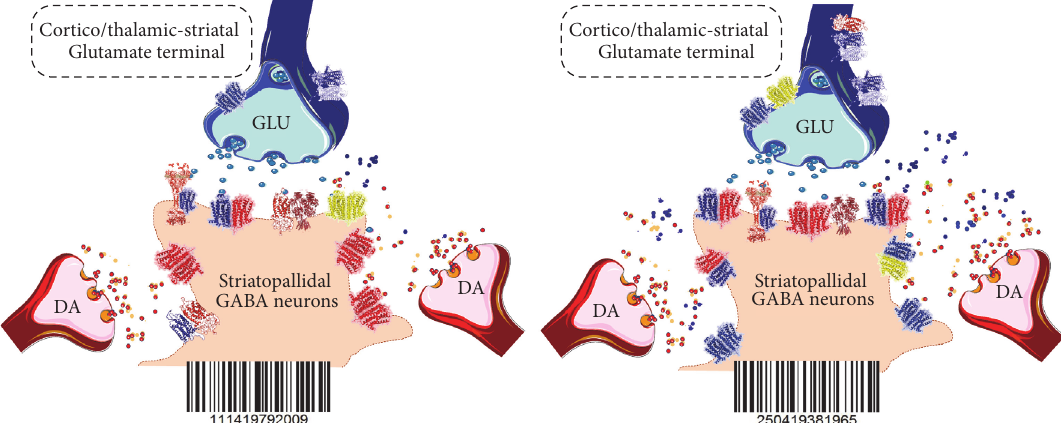
Figure 1: Illustration of possible reorganization of the homo- and heteroreceptor complexes within the synaptic and extrasynaptic regions of the glutamate synapses of the striatopallidal GABA neurons in the learning process. The receptor monomers are not illustrated. The left panel represents the basal state and the right panel the state that has developed in the learning process. They can become stabilized into a long lasting receptor assemblies through the formation of novel adaptor and scaffolding proteins. If so, they will represent short-term memory that can be converted into long-term memory through further